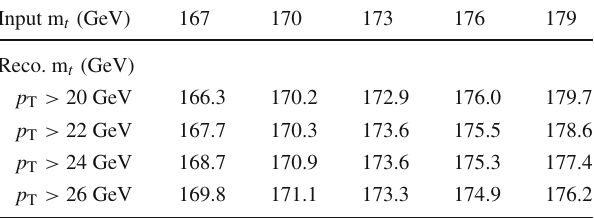
Table 2 Input and reconstructed masses for various lepton p T thresh- olds from 20 GeV to 26 GeV in steps of 2 GeV. The weight function for n = 2 is